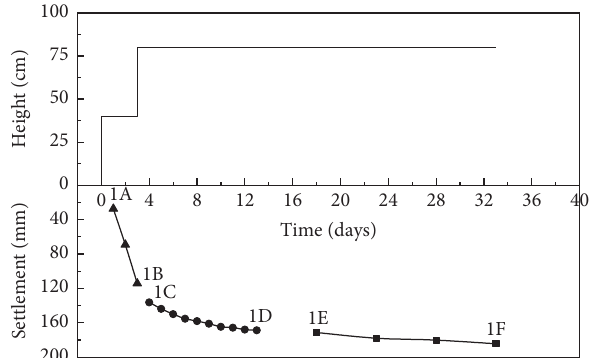
Figure 7: Fill height and settlement varying with time in the first stage.